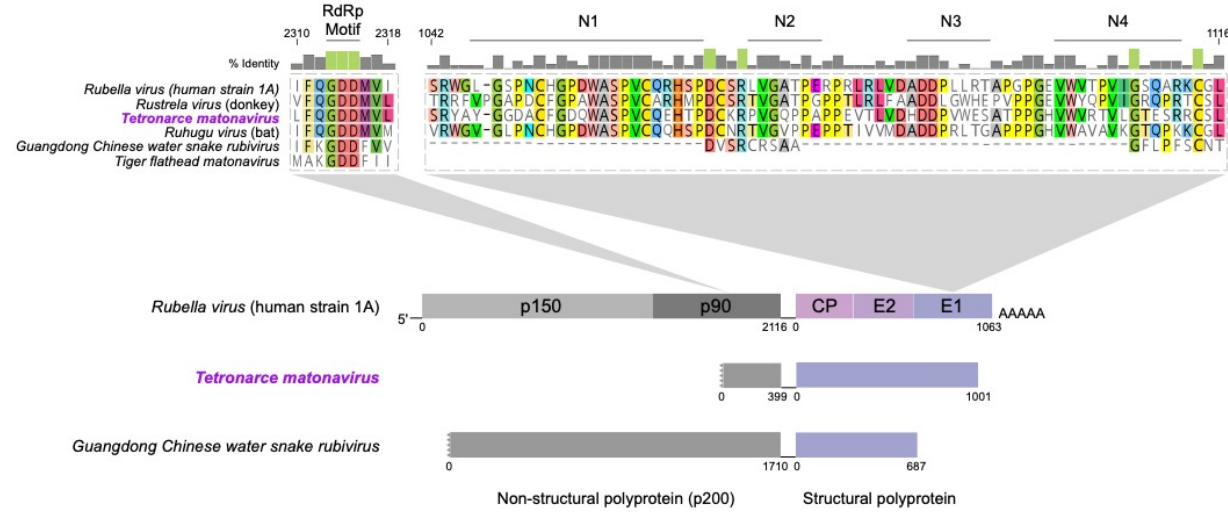
Figure 2. Conserved sequence motifs between human Rubella virus (strain 1A), Rustrela virus (donkey), Ruhugu virus (bat), Tetronarce matonavirus , Tiger flathead matonavirus , and Guangdong Chinese water snake rubivirus shown. The non-structural (p200) polyprotein contains a conserved GDD amino acid motif in the p90 (RdRp) protein at positions 2313–2315. Regions corresponding to RuV B cell epitopes N1–N4 within E1 in the structural protein alignment at positions 1042–1116 are also illustrated. Bar graphs of percentage identity (%) of residues shown above the alignments with identities of 100% highlighted green. Genomic organisation of Matonaviridae ( Rubella virus strain 1A) is shown below with segments able to be recovered from Tetronarce matonavirus and Guangdong Chinese water snake rubivirus indicated underneath for comparison. These comprise the complete structural polyprotein and partial non-structural polyproteins.